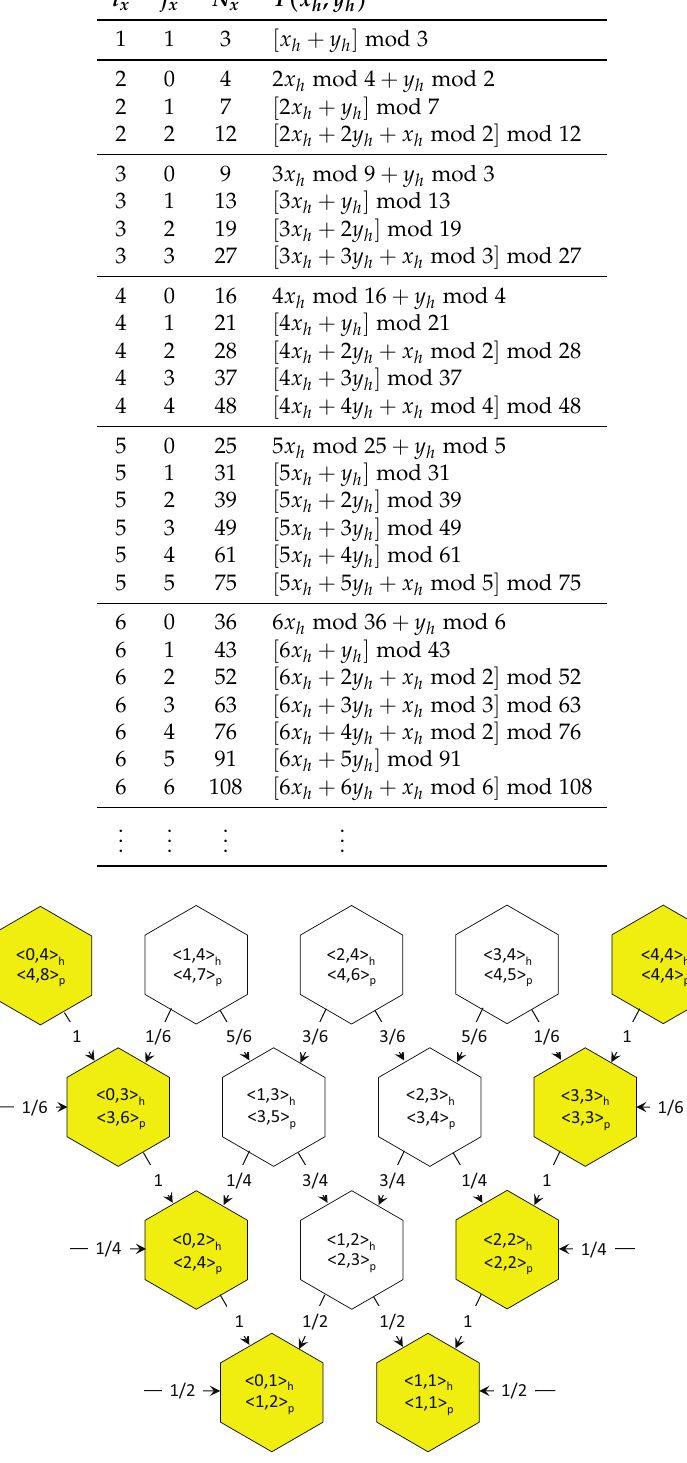
Table 3. Cluster Size N x = i 2 x + i x j x + j 2 x , ( x = N intra , N inter ) and Slot Assignment for Transmission for any CH (cid:104) x , y (cid:105) h .